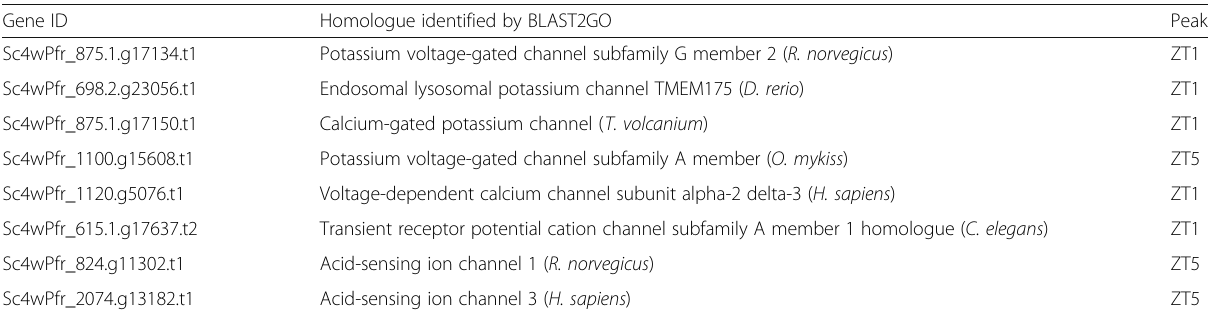
Table 1 Putative channel genes exhibiting diel expression patterns Gene